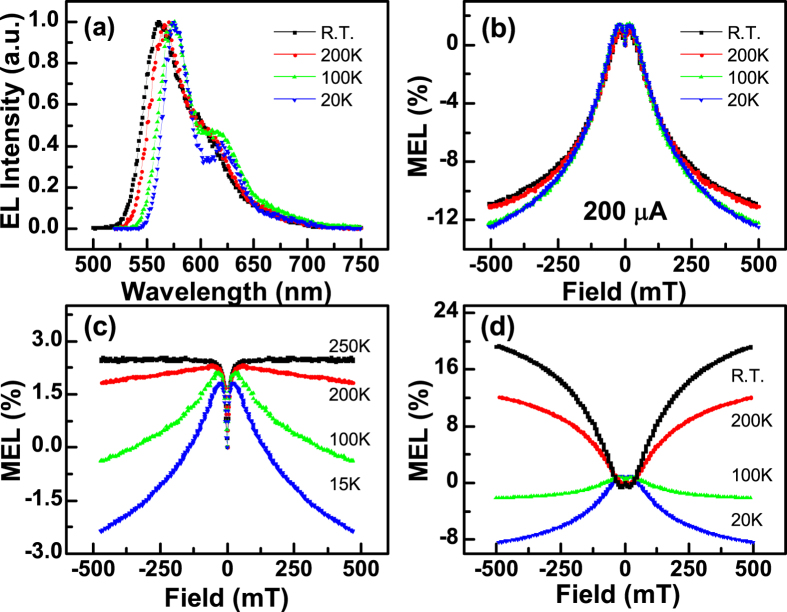
(a) EL spectra of device I at R.T., 200 K, 100 K and 20 K. (b–d) MEL responses at different temperatures for device I, Alq3 based OLED30 and conventional rubrene-based OLED13, respectively.